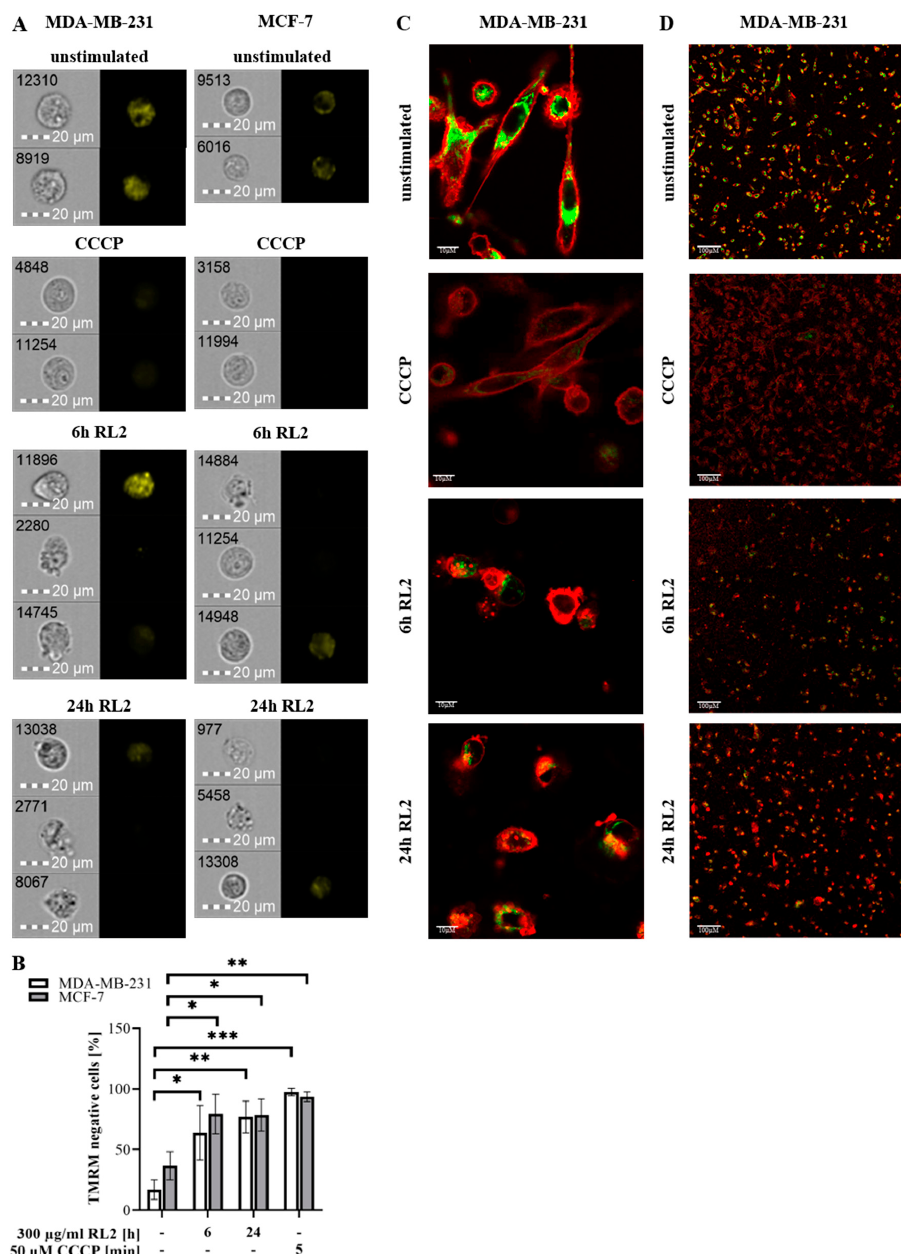
Figure 6. RL2 induces loss of mitochondrial membrane potential. ( A – D ) MDA-MB-231 and MCF-7 cells were stimulated with 300 µ g / mL RL2 for 6 and 24 h. Cells were subsequently stained with 20 µ M TMRM. The reduced TMRM signal indicated the loss of mitochondrial membrane potential. CCCP treatment served as positive control for TMRM reduction. ( A ) Cells were analyzed with FlowSight ® for TMRM-signal. Representative cells from three independent experiments are shown. ( B ) Mean and standard deviations for the amounts of TMRM negative cells (in %) from three independent experiments are shown. The statistical analysis was performed by paired student t-tests. ( C , D ) RL2-treated MDA-MB-231 cells were stained with 5 mg / mL cell membrane stain (CellMask ™ Deep Red Plasma membrane Stain, C10046, Thermo Fisher, Walham, MA, USA) and introduced to confocal laser scanning microscopy. Membrane- and TMRM-stained cells are shown in merge for single cells ( C , scale: 10 µ M) and cell populations ( D , scale: 100 µ M). The red color corresponds to the plasma membrane staining. The green ( C ) and yellow ( A , B ) colors correspond to TMRM staining. * (significant; p < 0.05), ** (significant; p < 0.01), *** (significant; p <